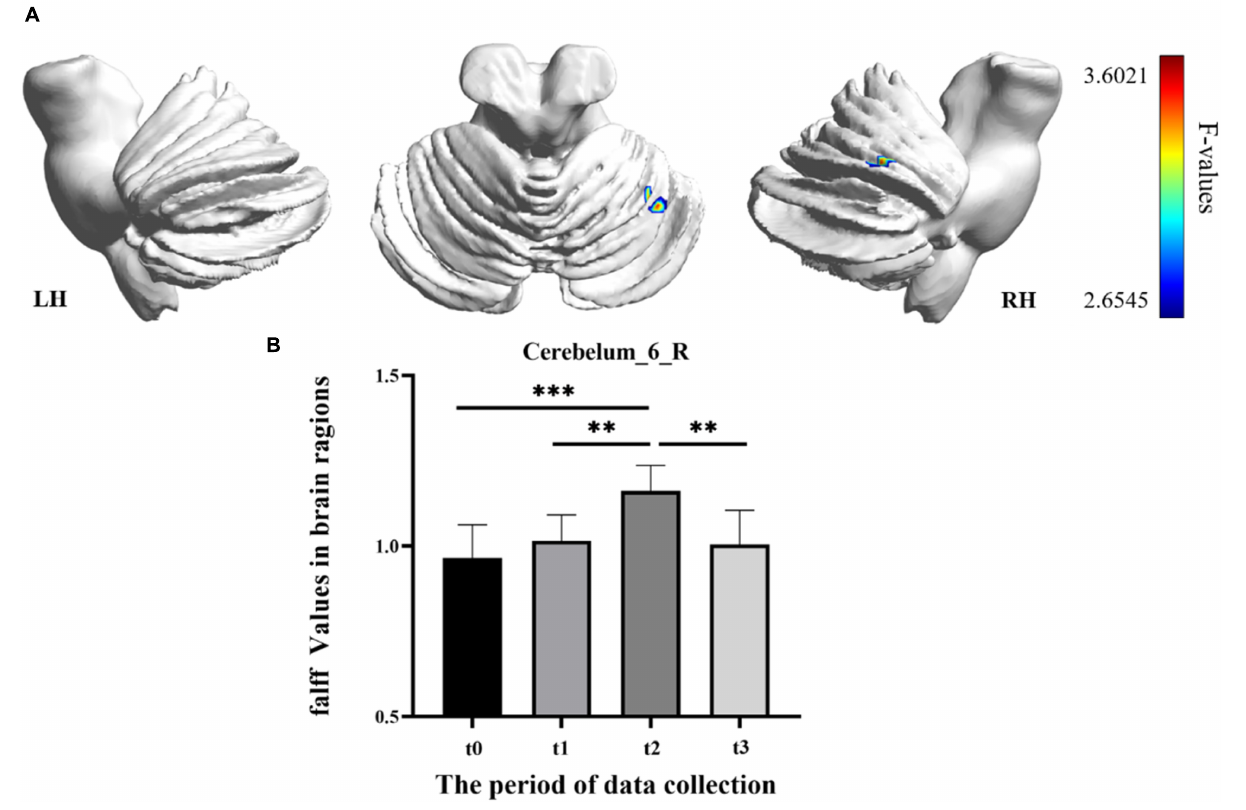
FIGURE 3 | The fractional amplitude of low-frequency fluctuation (fALFF) differences among different time-subgroups. (A) One-way repeated-measure ANOVA showed brain regions with fALFF differences among four subgroups in the Cerebelum_6_R. The color bar indicated the F scores. (B) Bar plots showed the fALFF values of the Cerebelum_6_R at four different time-subgroups. Cerebelum_6_R, right cerebellum posterior lobe VI; t0, t1, t2, and t3, different time subgroups; LH, left hemisphere; RH, right hemisphere, ∗ indicates a significant difference in the two groups. ∗ p < < 0.05, ∗∗ p < 0.01, ∗∗∗ p < 0.005.